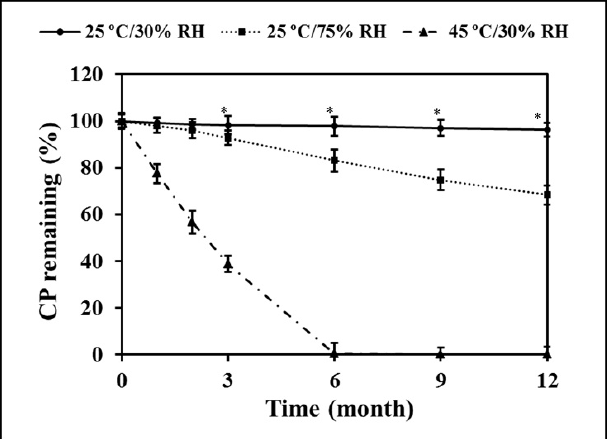
Figure 8. CP remaining in CP-F during long-term storage in the various conditions. * Significant difference in the amount of CP in comparison to other storage conditions ( p < 0.05).